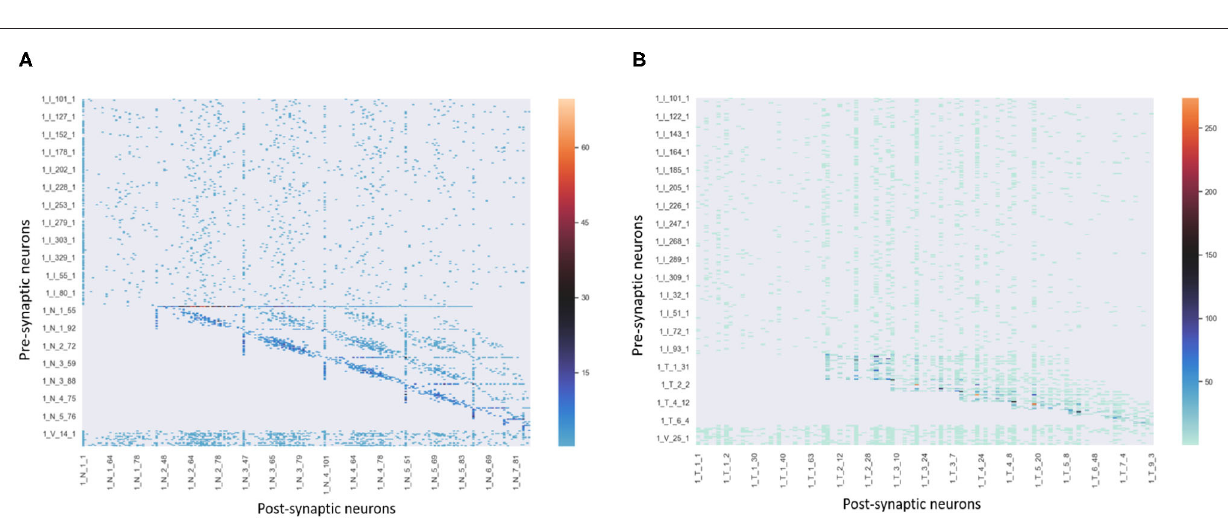
FIGURE 5 | The neural oscillations in the learning process. Neurons preferred external stimulations including “Classical,” “Mozart,” “Sonate C Major” and related pitches have theta activities. Other neurons stay silent since they are not triggered.